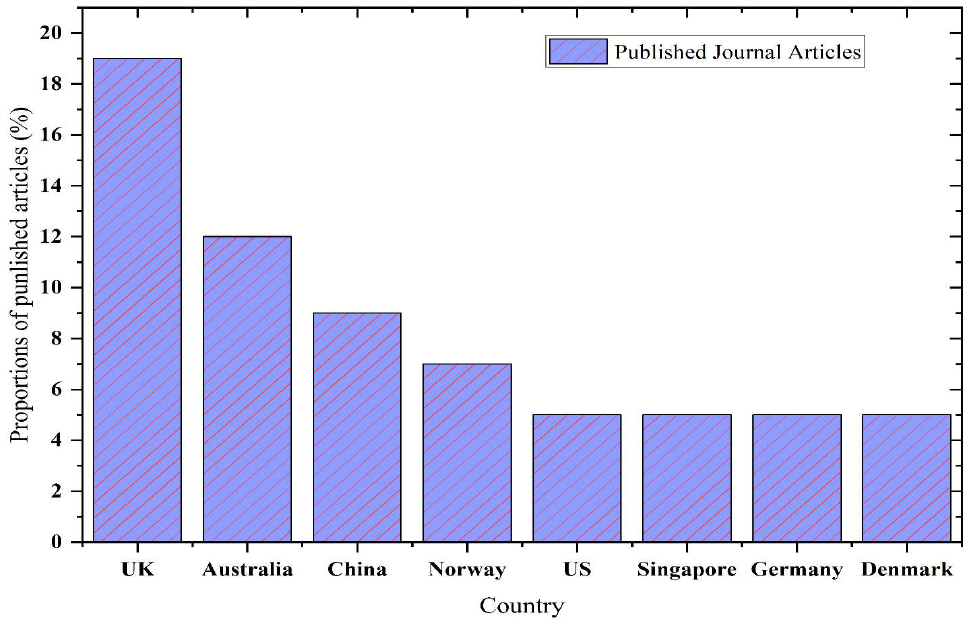
Figure 2. The proportions of published journal papers on P2P energy trading by country. Reprinted with permission from [22]. Copyright 2022, Elsevier.